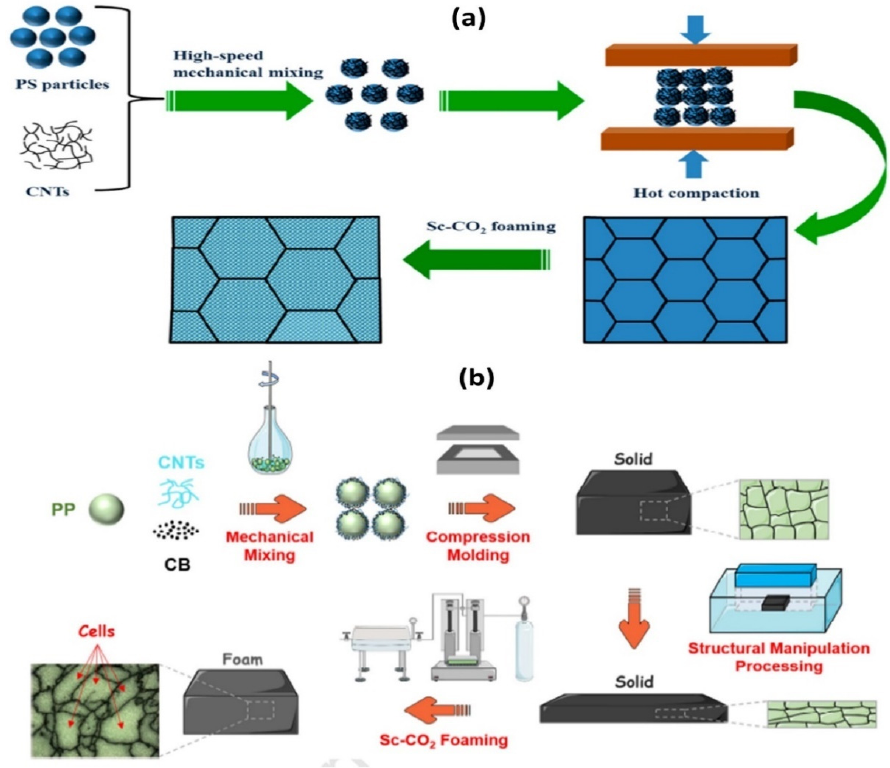
Figure 9. ( a ) Schematic depicting the fabrication of a segregated structure within porous PS/MWCNT composites. Reproduced with permission from [109]. Copyright 2019, American Chemical Society. ( b ) Schematic demonstrating the formation of a double-segregated structure within PP/CNTs/CB nanocomposite foams. Reproduced with permission from [110]. Copyright